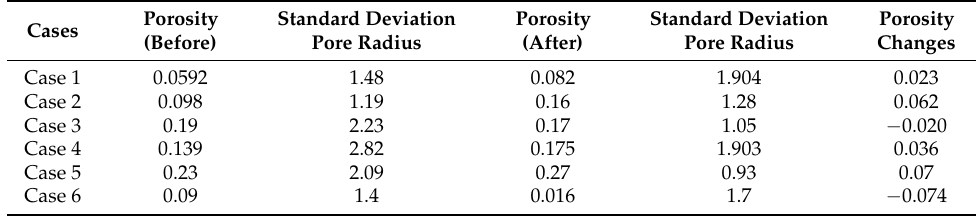
Table 8. Porosity changes before and after the